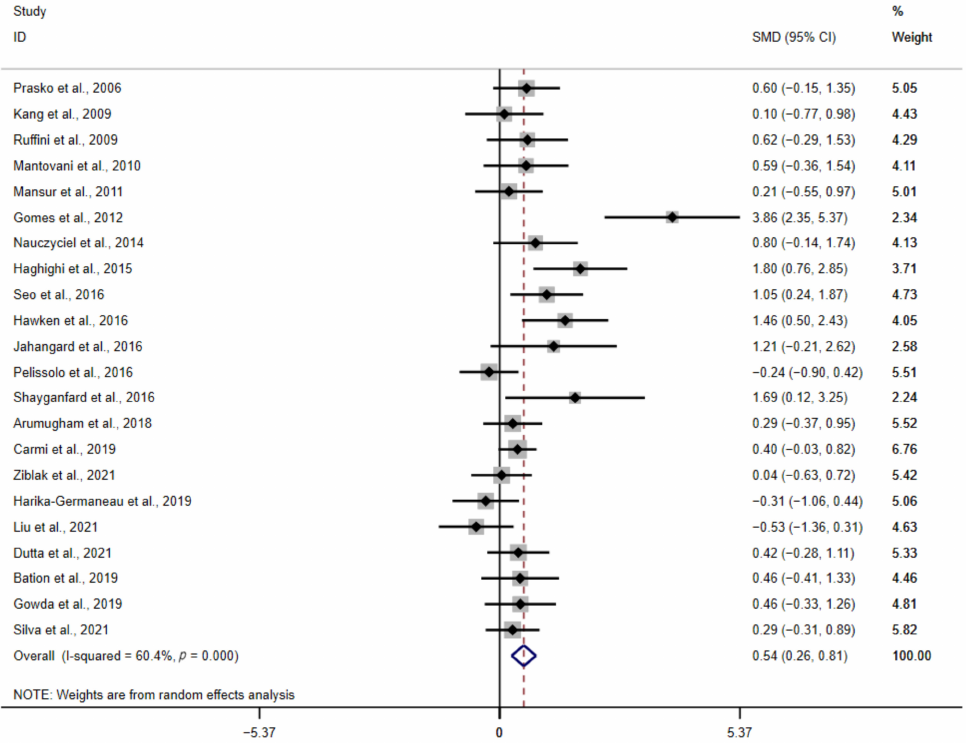
Figure 2. Forest plot of the meta-analysis for the therapeutic effects [23,25–36,38–46]. Bias test and sensitivity test were conducted to find out the cause of heterogeneity.